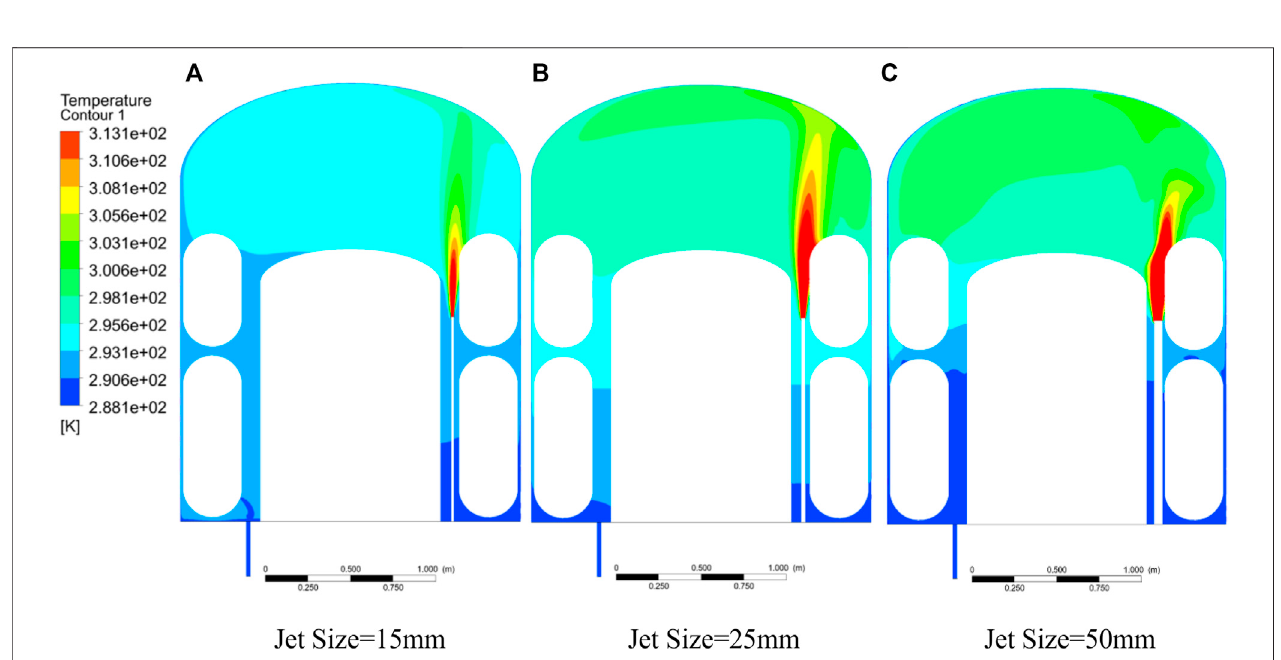
FIGURE 12 | Temperature fi led of the containment at different jet diameters. (A) Jet size = 15 mm. (B) Jet size = 25 mm. (C) Jet size = 50 mm.